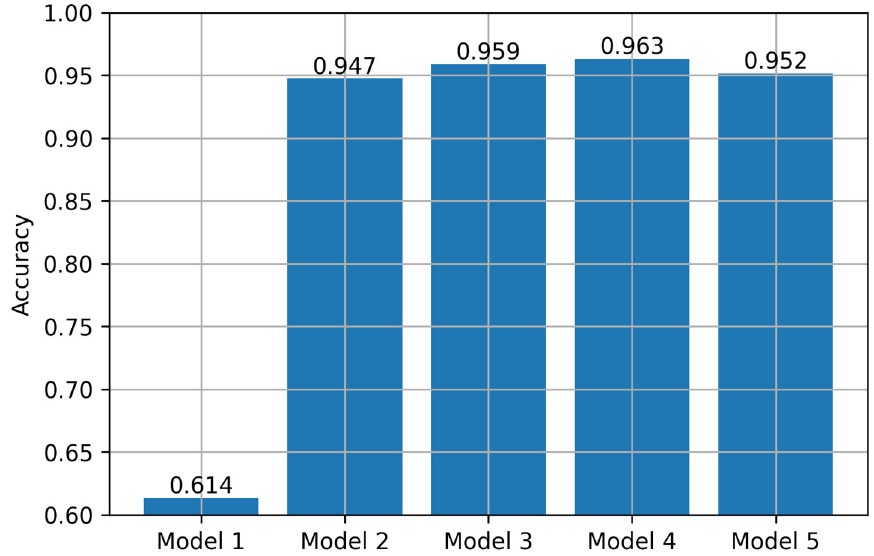
Figure 16. Accuracy of ResNet50 models.